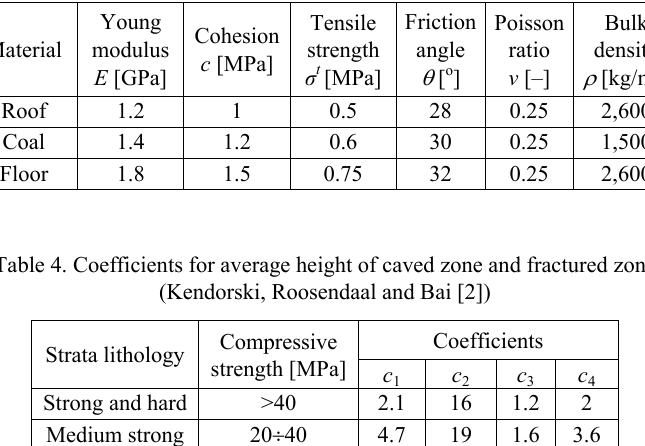
Table 3. Mechanical parameters of the rock mass used in numerical modeling